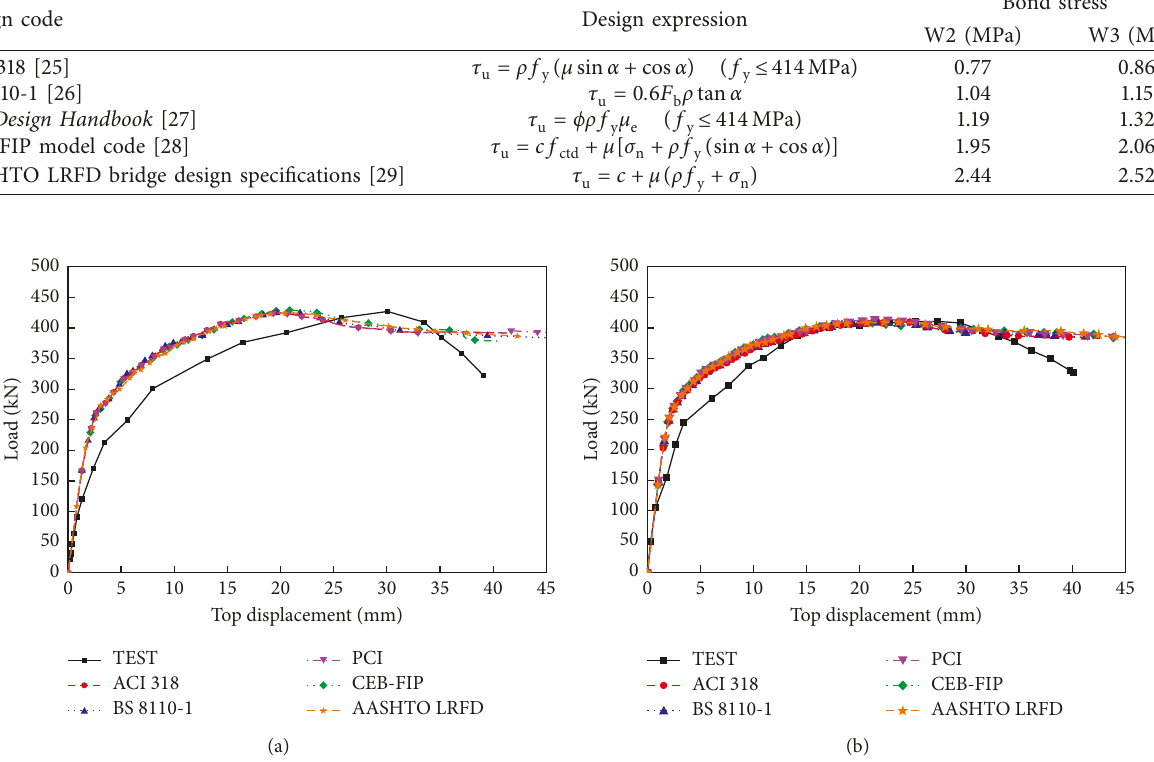
Table 3: Design expressions of different design codes to calculate the bond strength. Design code